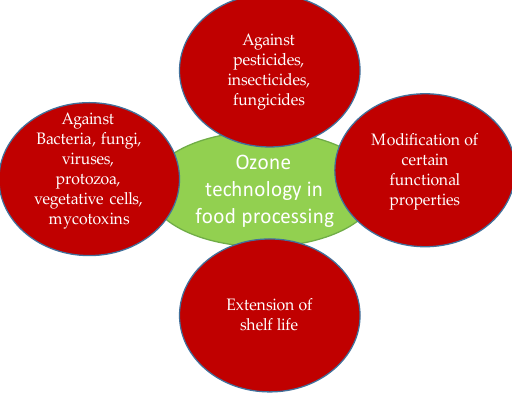
Figure 5. Use of ozone technology in food